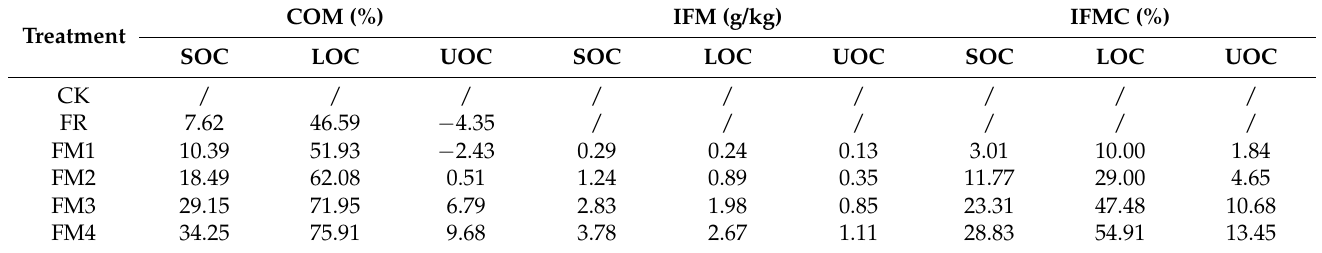
Table 5. Contribution of different fertilization treatments to SOC fraction and effects of interaction of chemical fertilizer and organic manure on the SOC